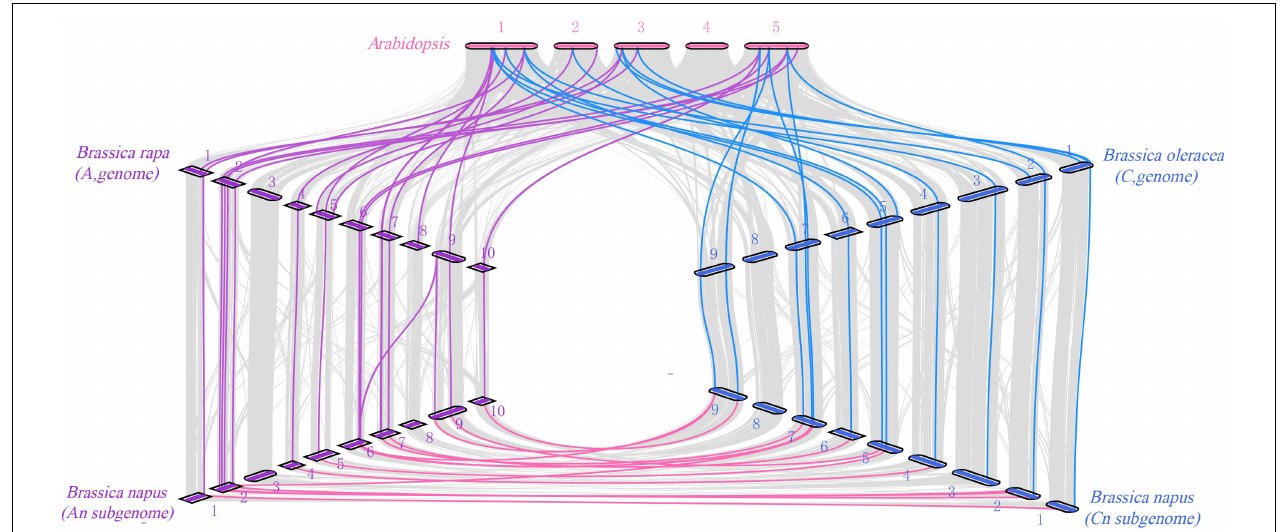
FIGURE 5 | Syntenic relationship of COL genes in B. napus and three ancestral plant species. The figure shows the collinearity between Arabidopsis ( A. thaliana ), Brassica rape ( B. rapa ), Brassica oleracea ( B. oleracea ), and Brassica napus ( B. napus